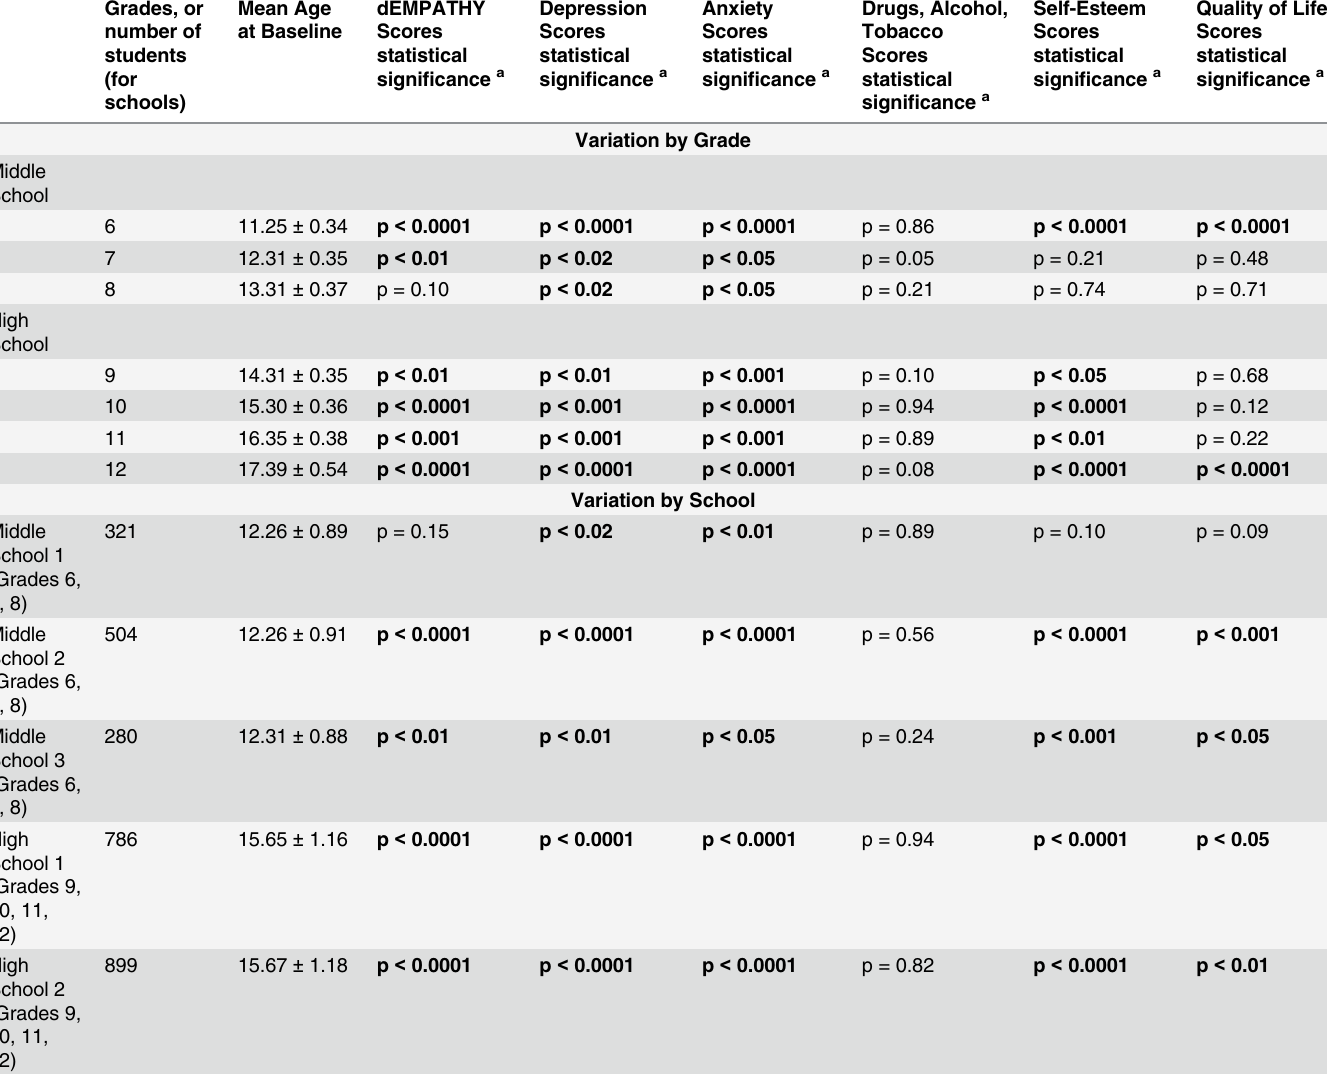
Table 3. Variation by Grade and by School: change from baseline to 12-week follow-up. Grades, or number of